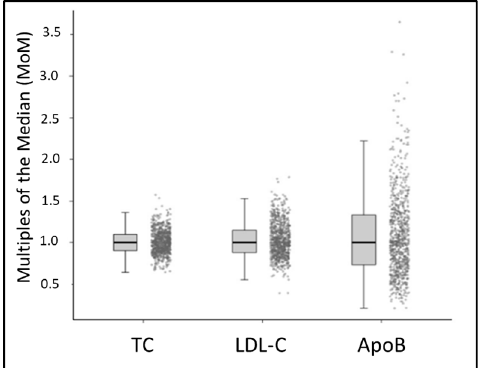
Figure 3. Evaluation of presumptively unaffected population. Multiples of the median for total cholesterol (TC), low-density lipoprotein (LDL-C), and apolipoprotein B (ApoB) in 820 newborn specimens collected within 24–72 h after